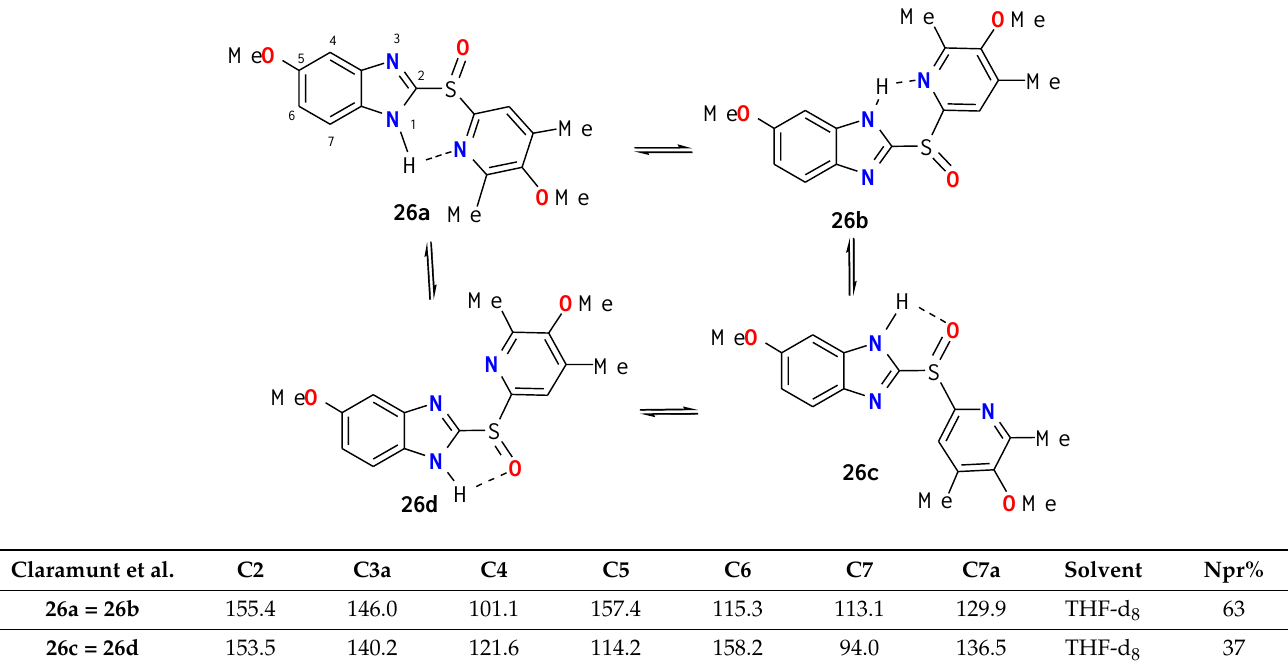
Table 9. Tautomers of omeprazole in THF.